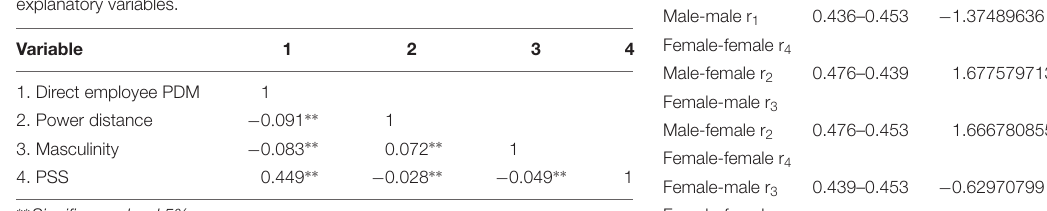
TABLE 5 | Linear correlation coefficients between PDM and the explanatory variables.